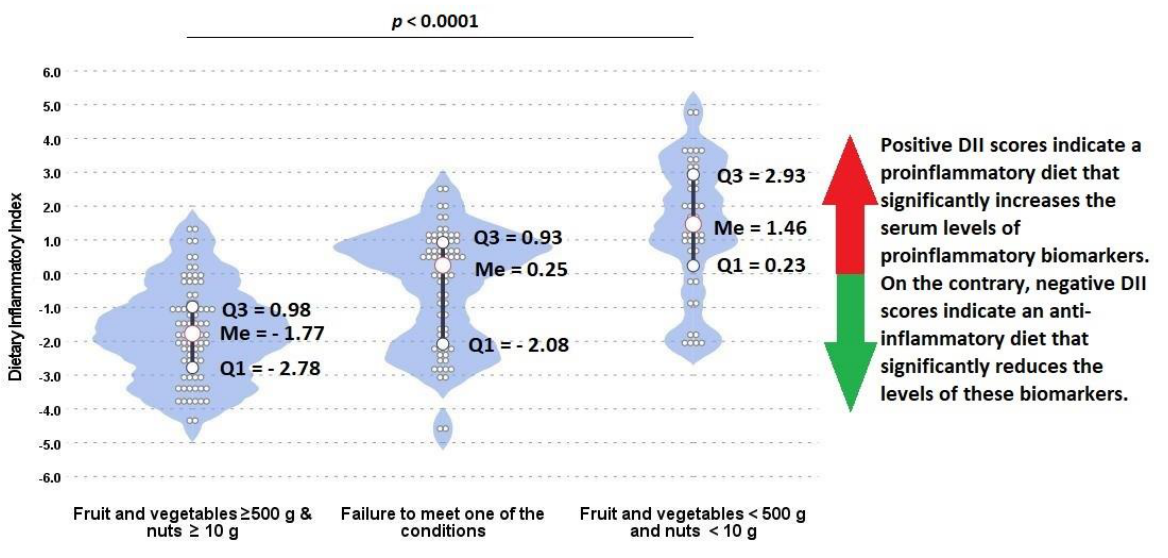
Figure 6. Associations between the consumption of vegetables, fruits, and nuts and Dietary Inflamma- tory Index among participants. Wider areas on violin plots refer to higher probability of occurrence. Q1, Q3, Me: quartiles and median of distribution.